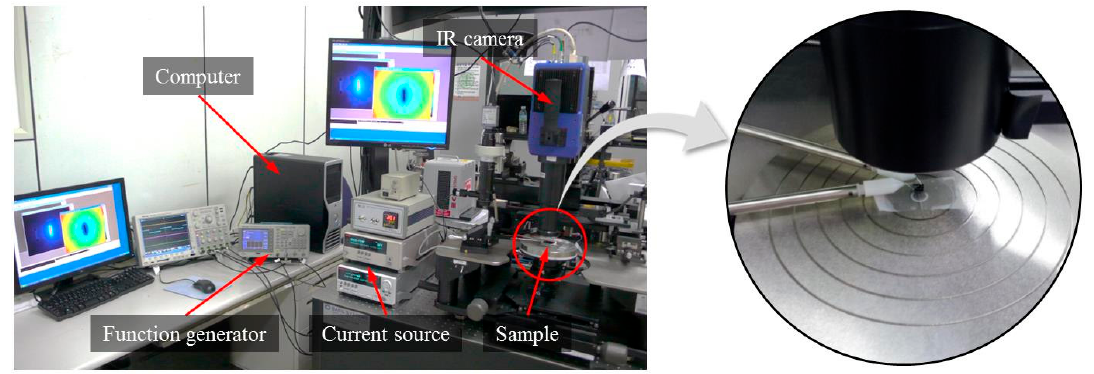
Figure 3. Infrared lock-in microscope system.